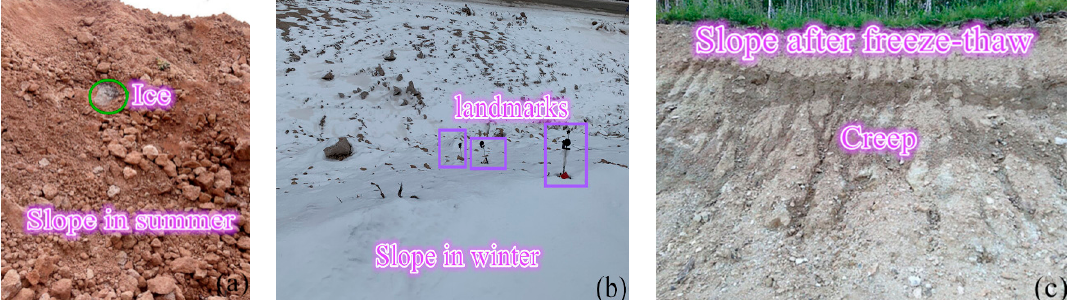
Figure 13. Physical map of the cutting slope. ( a ) The exposed ice can still be seen in the slope in summer due to the high ice content. At the same time, this also illustrates a serious problem, that is, the slope is melting. ( b ) In order to capture the dynamic change process of the slope during the freeze-thaw cycles, we set landmarks on the slope and continued to collect data throughout the year, including winter. ( c ) The freeze-thaw cycles result in a down-slope creeping of the shallow soil layer, leading to progressive slope failure.